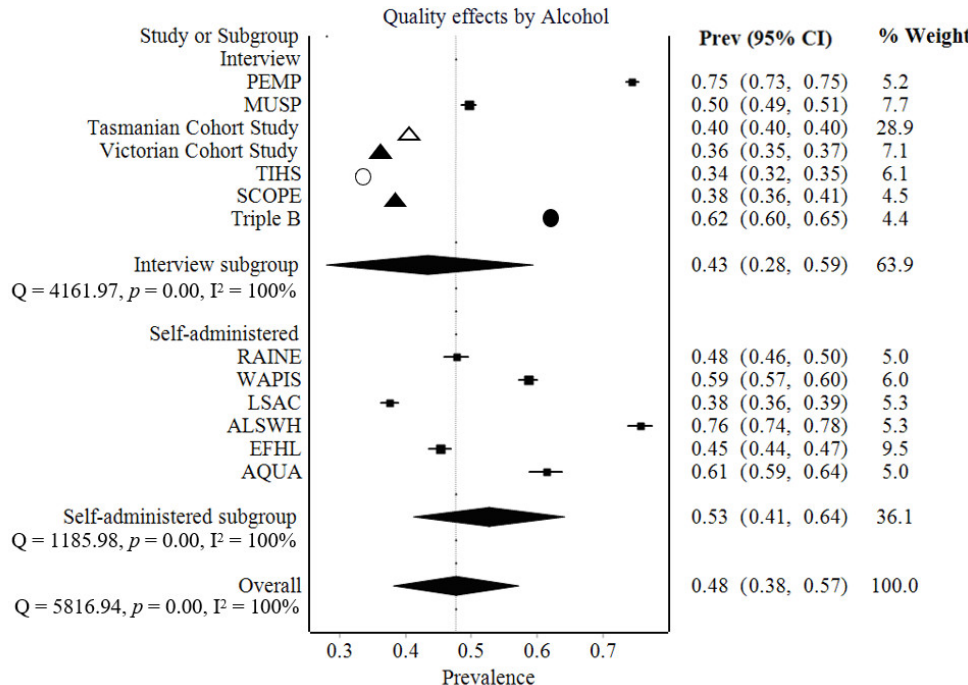
Figure 2. Forest plots displaying prevalence estimates with 95% confidence interval (CI) and subgroup analysis for alcohol exposure at any time during pregnancy for cohorts in which information on PAE was collected using self-administered survey-based methods and interview-based methods. I 2 , between study heterogeneity; Q, Cochran’s Q; p, statistical significance. For each cohort, the prevalence rate reported by the publication using the largest sample of that cohort is shown. An overall prevalence value was not given for the NDSHS 2010 cohort, where the value prior to pregnancy recognition was used. The Triple B study used trained assessors to collect interview information. The Hunter New England Cohort and the NDSHS Cohort from 2001 to 2007 were excluded due to only reporting prevalence after awareness. The NDSHS Cohort from 2010 and the Barwon Infant Study were excluded due to small sample size reporting overall prevalence ( n < 1000, despite overall cohort size n > 1000). Triple B and AQUA cohorts differentiated between pre- and post-recognition of pregnancy. For the interview subgroup, open triangle represents doctor, closed triangle represents midwife, open circle represents research assistant/research midwife, and closed circle represents trained assessor. Boxes in the interview subgroup represent studies where the assessor was unclear. Results suggest that while overall self-administered surveys generated higher prevalence estimates than interview-based methods, and the use of trained assessors in interview settings resulted in high PAE